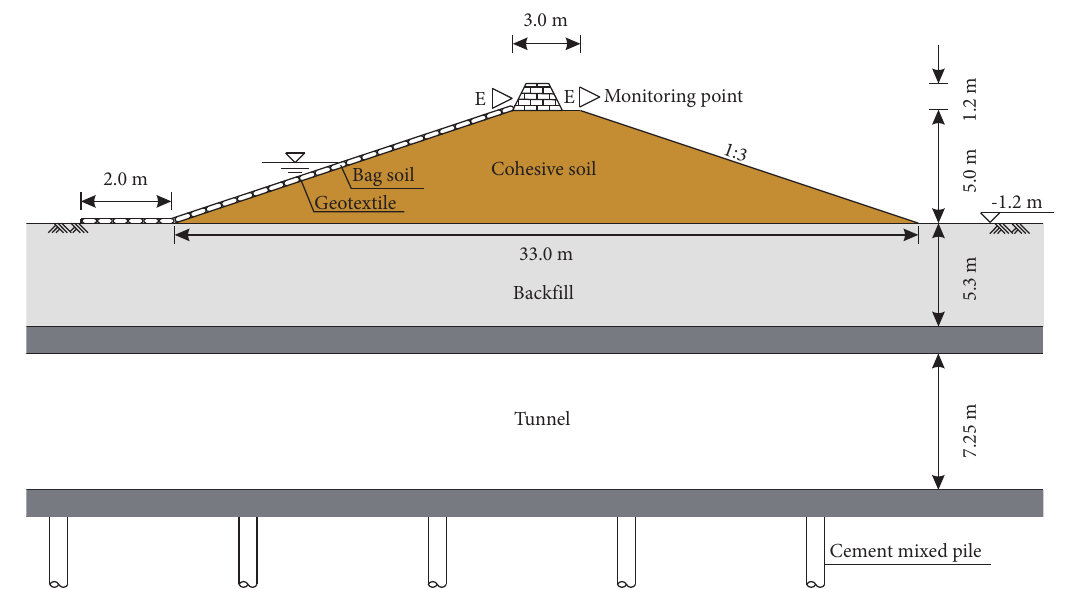
Figure 6: Cross section of the earth cofferdam located between WSS and Zone #1 along the tunnel Table 1: Main construction stages of Zone #1.